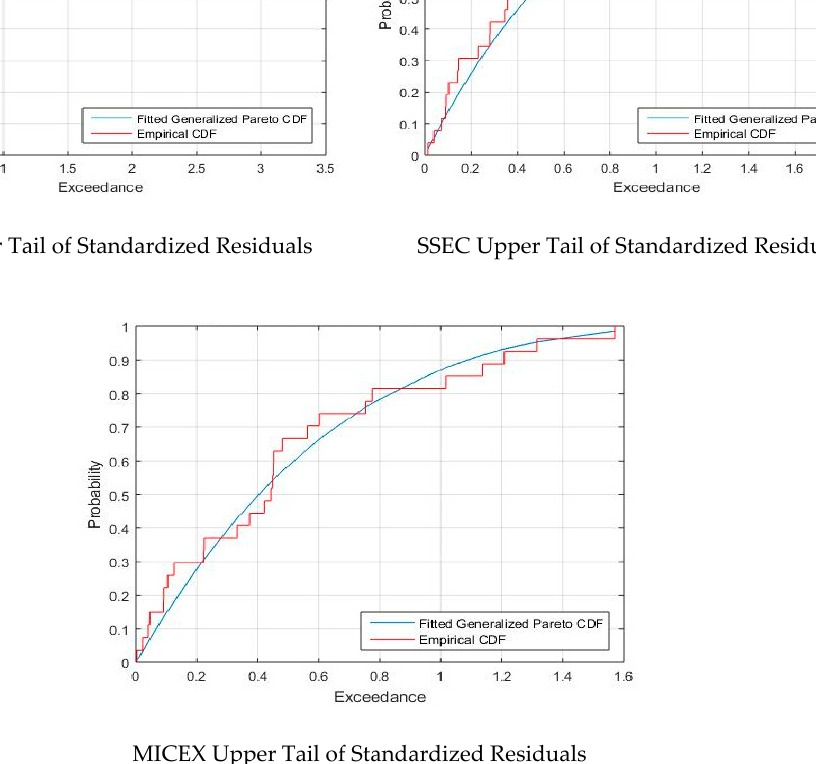
Figure A2. Out-of-Sample VaR Figures.